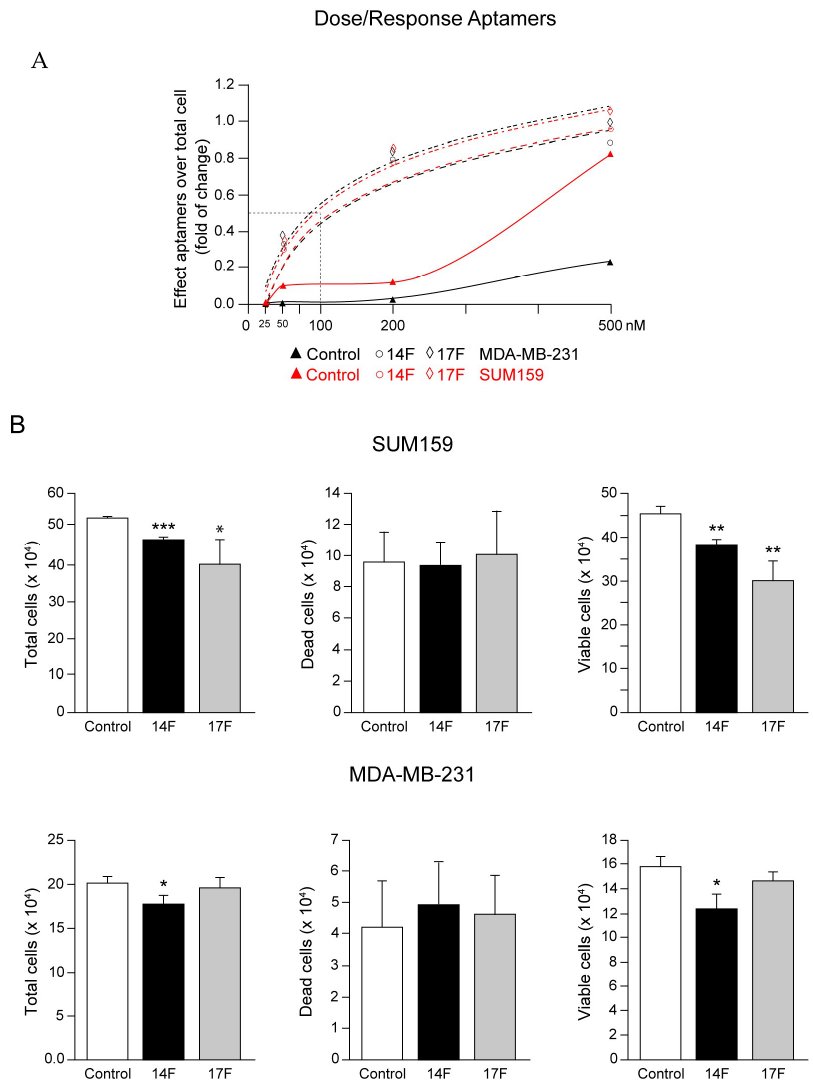
Figure 5. Dose/response of SH2-c-Src directed aptamers in SUM159 and MDA-MB-231 cells and evaluation of cell proliferation. ( A ) Control aptamer (38xAG) and SH2-c-Src directed aptamers 14F and 17F were transfected at 25, 50, 200, and 500 nM to SUM159 and MDA-MB-231and the IC50 values were determined as described in Material and Methods ( n = 3). ( B ) Control and SH2-c-Src directed aptamers 14F and 17F were transfected at 100 nM to either SUM159 or MDA-MB-231 and, 72 h later, the number of total, dead, and viable cells were determined by the trypan blue exclusion method (see Materials and Methods). Each experiment was measured in triplicates ( n = 3) and repeated three times. Results were expressed as a percentage of the mean ± SD, * p < 0.5, ** p < 0.01, *** p <